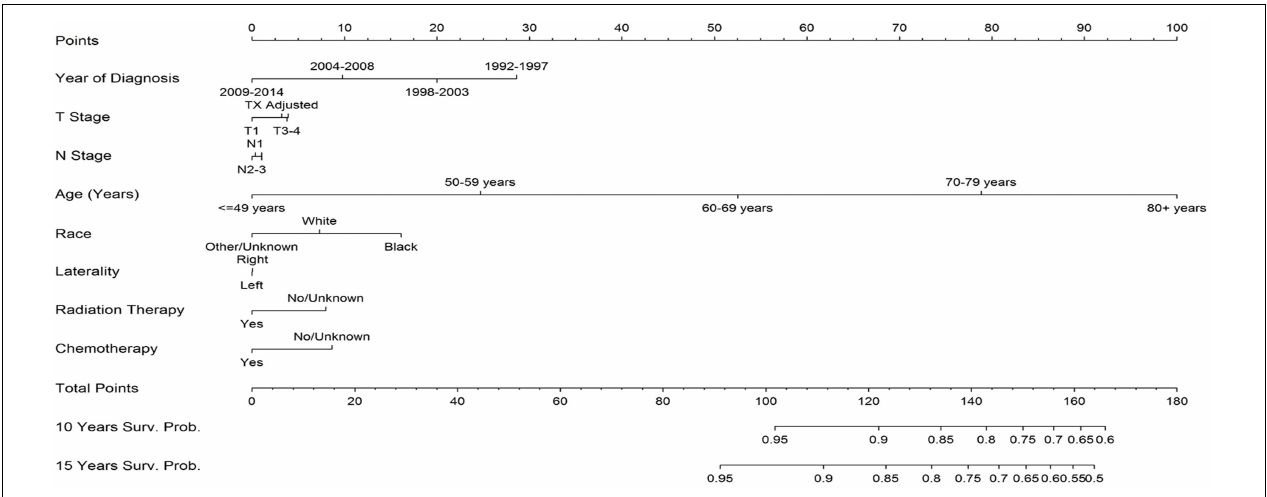
FIGURE 3 | Nomogram for likelihood of breast cancer patients dying from heart disease. The two greatest predictors of death from heart disease are earlier year of diagnosis and older age. Disease laterality does not provide meaning predictive insight into death from heart disease. Receipt of chemotherapy and radiation therapy have a relative minimal impact of death from heart disease; in this part of the analysis they have a paradoxical protective effect because of bias in selecting patients for the treatment. To use the nomogram, sum each patient’s characteristic to get a total point sum which can then be used to predict the patient’s survival probability.